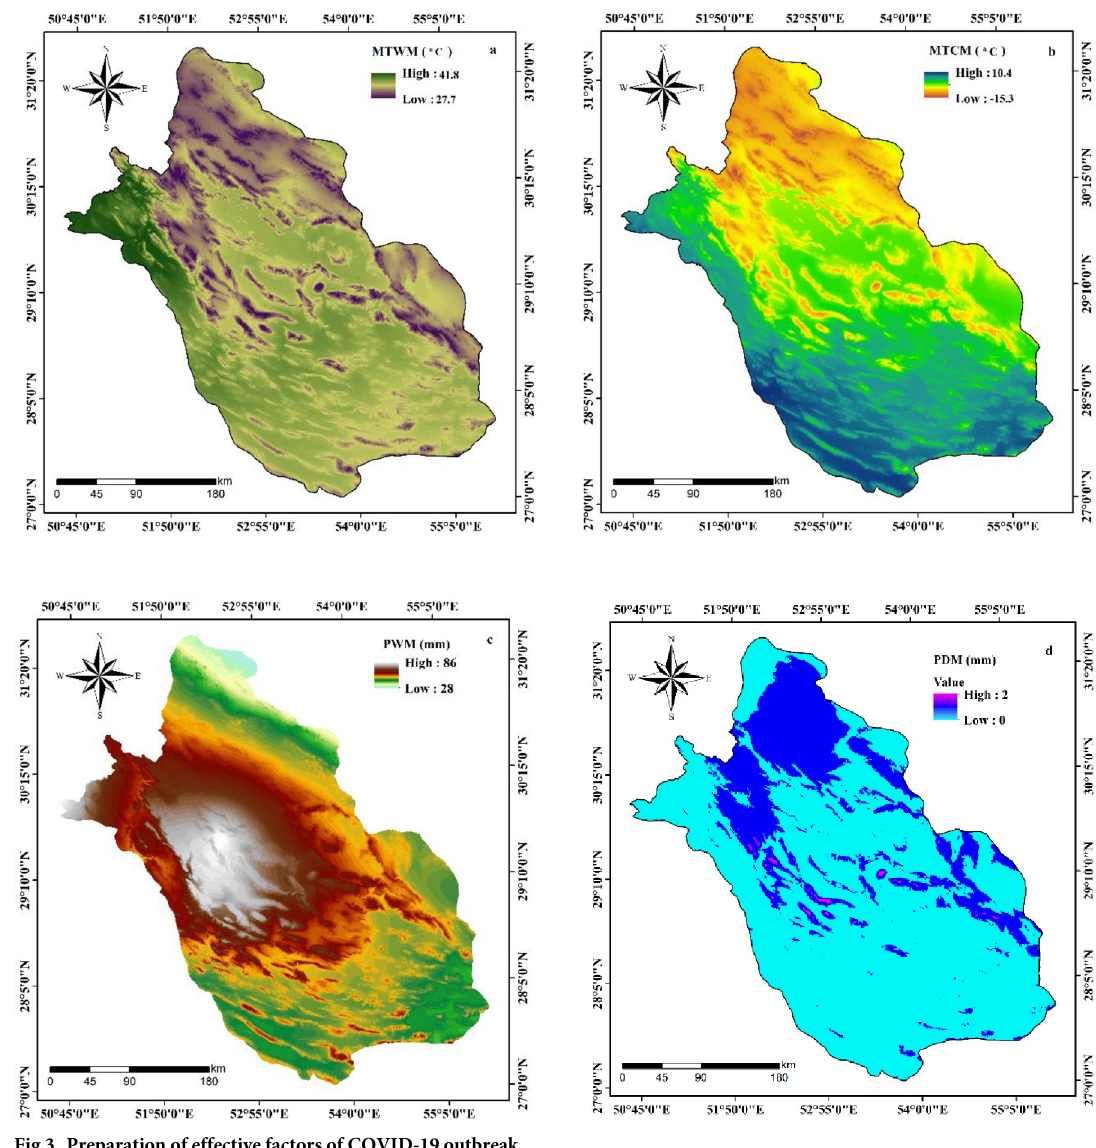
Fig 3. Preparation of effective factors of COVID-19